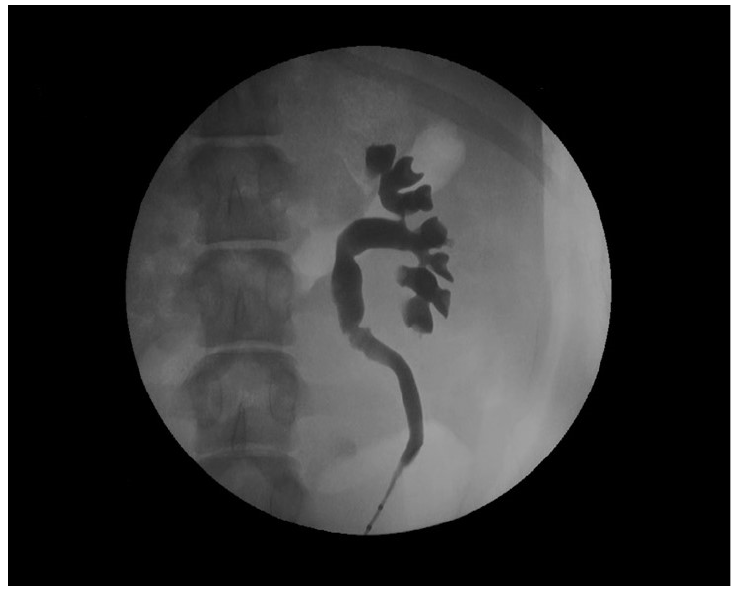
Figure 4. Retrograde ureteropyelography of a porcine left nephroureteral unit.